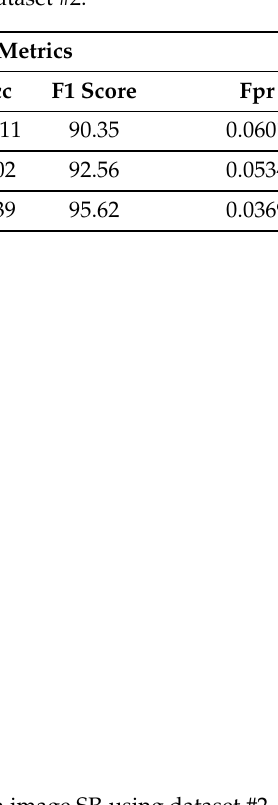
Figure 10. Confusion matrix for InceptionResnetv2 model with image SR using dataset